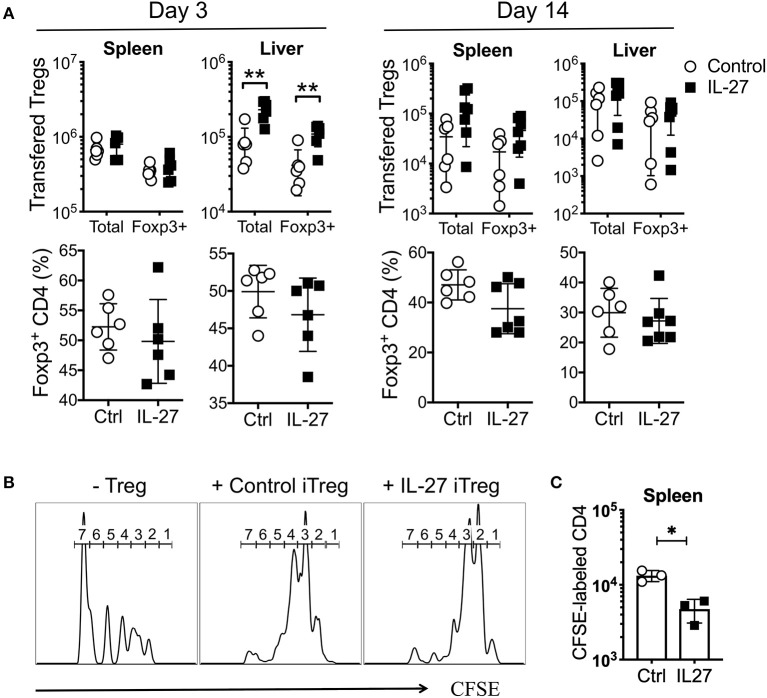
IL-27 did not affect Treg stability, but enhanced their suppressive function in vivo. Mice were induced aGvHD and transferred with Control or IL-27 pre-treated allogeneic iTregs (CD45.1) as in Figure 4. Mice were sacrificed at day 3 and 14 post-transfer. (A) Percentage of Foxp3+CD4 cells in transferred Treg population and number of transferred Tregs were determined in spleen and liver. (B,C)
In vivo suppression assay. Sublethally irradiated B6 mice were intravenously injected with a mixture of CFSE-labeled naïve CD4 T cells and iTregs (ratio 1:1). (B) CFSE dilution was measured at day 14 in spleen. Histograms are the representatives of 5–7 mice per group. The numbers indicate the number of cell divisions. (C) The number of CFSE-labeled donor T cells was determined in spleen at day 14. Data are mean ± SEM. *p < 0.05, **p < 0.01.